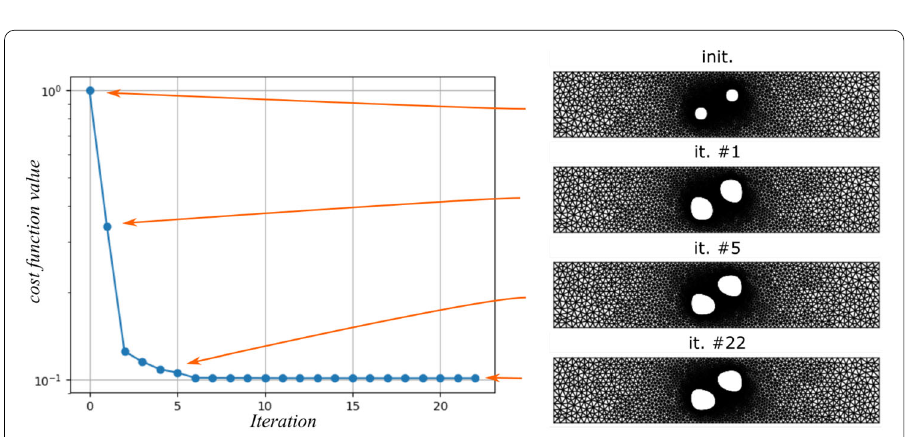
Fig. 11 Example of the orthotropic plate with two holes: evolution of the cost function value and specimen shape as a function of the iteration number in the first optimization run